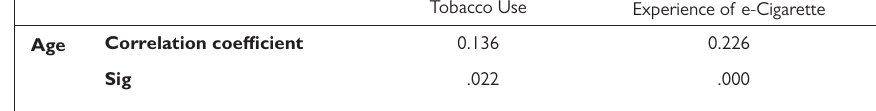
Table 2. Correlation Between Age and Tobacco Use and e-Cigarette Experience